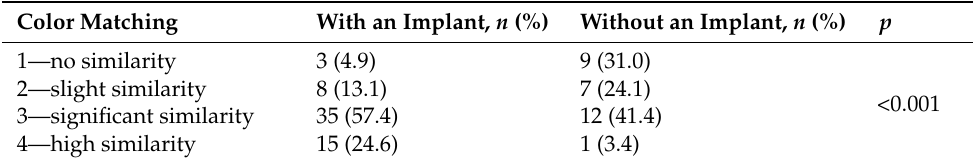
Table 4. Assessment of color matching between prosthetic and healthy eye in patients with and